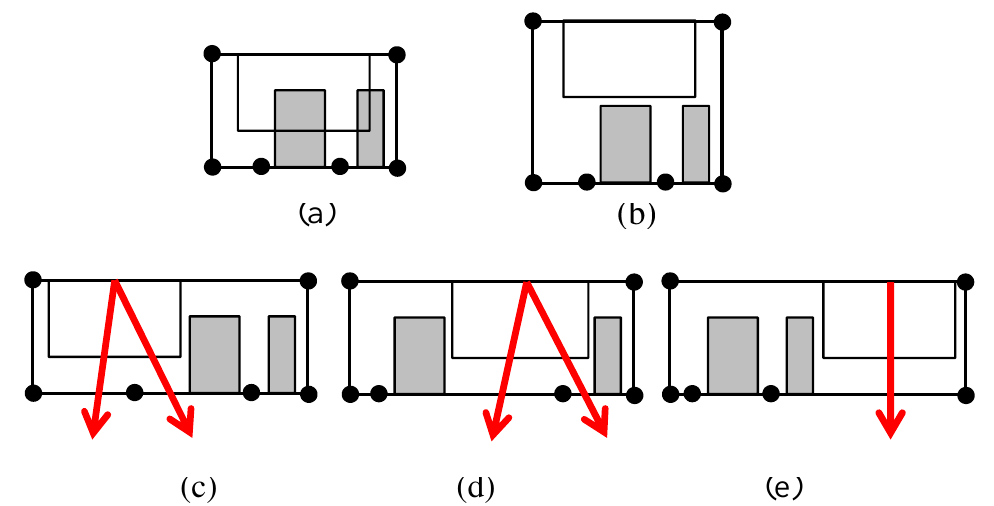
Figure 12. ( a ) A complex case of overlaps; ( b ) we resolve overlaps by increasing the height of the drawing. In ( c – e ), we resolve overlaps by increasing the width of the drawing. In addition, all possible partial orders are presented, and the arrows show how the space will open.